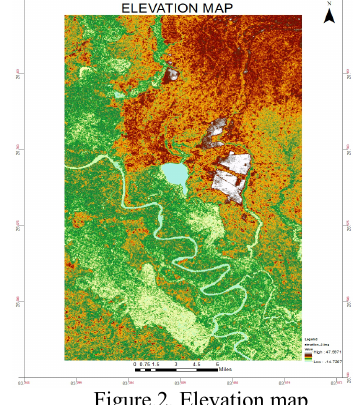
Figure.2. Elevation